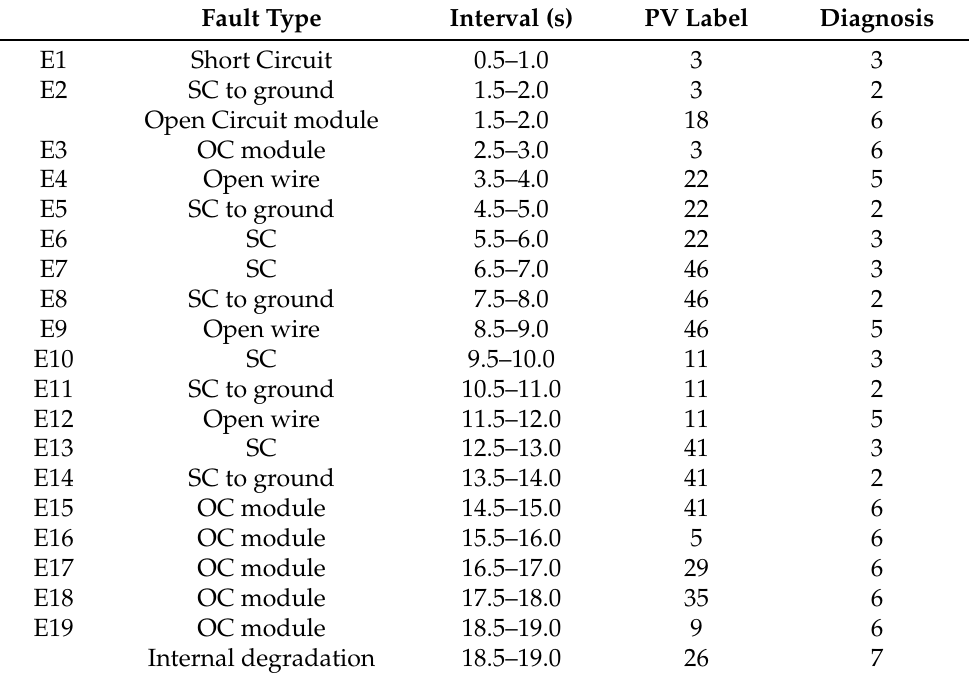
Table 5. Programmed events applied to the PV plant and the expected diagnosis